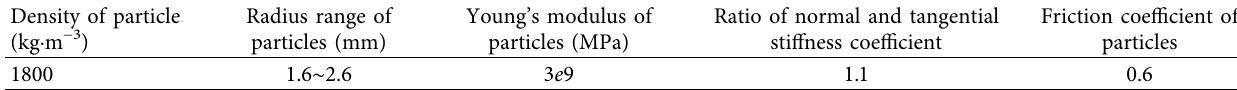
Table 3: Mechanical parameters of coal particles.